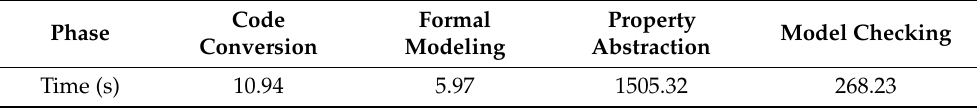
Table 5. Classification results of large families with